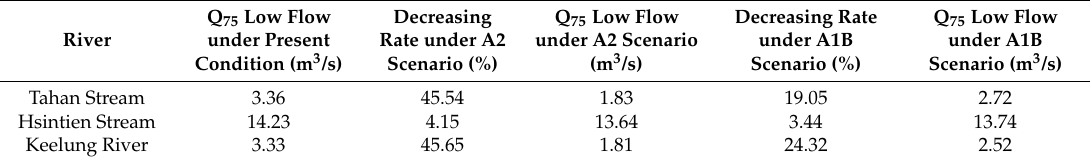
Table 6. The streamflows for the present condition and under climate change scenarios during Q75 low